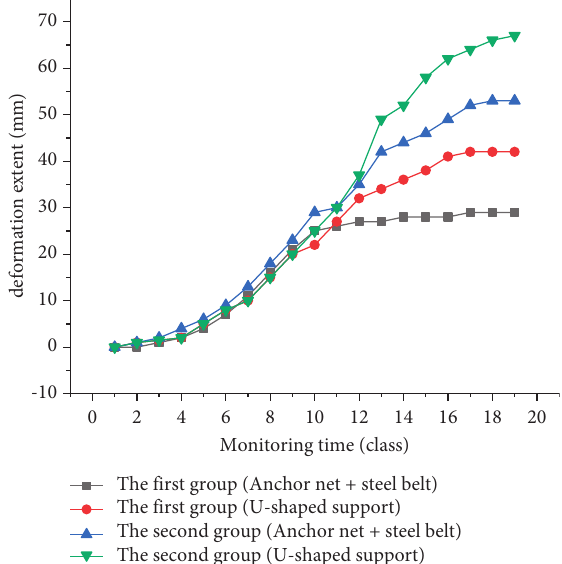
Figure 11: Field curves of deformation versus monitoring